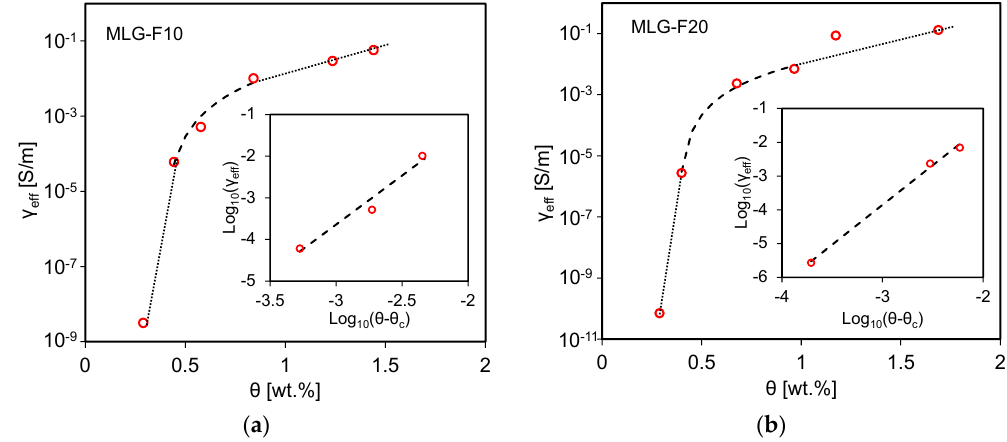
Figure 11. Effective DC conductivity of samples of the ( a ) MLG-F10; and ( b ) MLG-F20 foam types, for different weight concentration of MLGs.